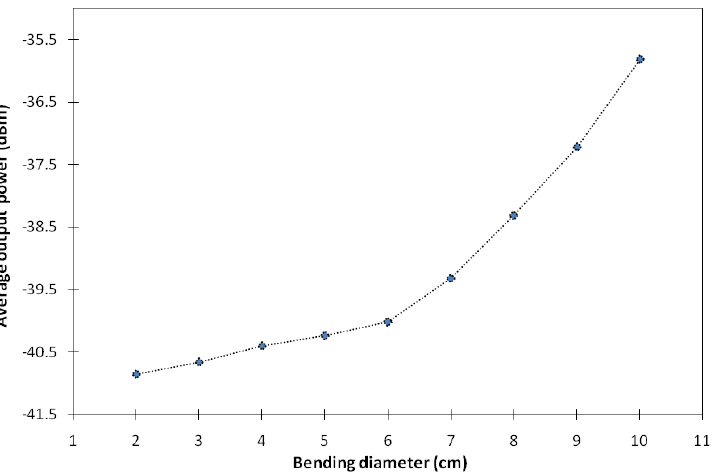
Figure 5. The average output power against the bending